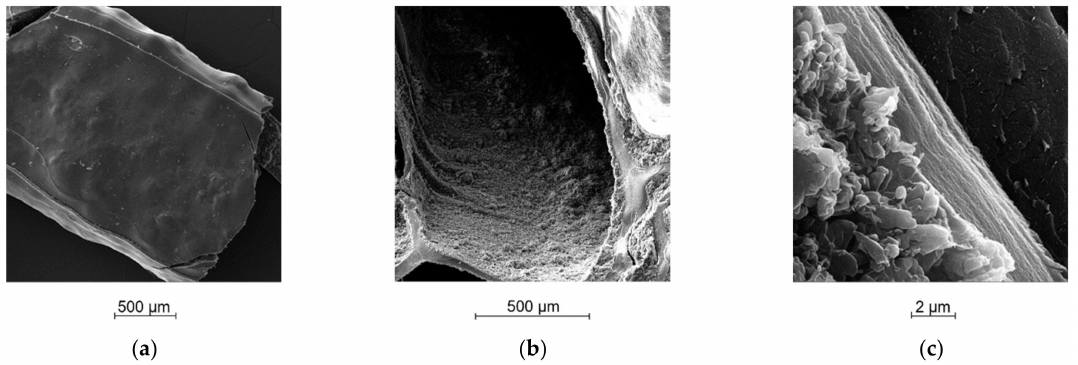
Figure 5. SEM acquisition of: ( a ) external view of single layer after drying; ( b ) a cross-section view of DDS; ( c ) a longitudinal-section view of